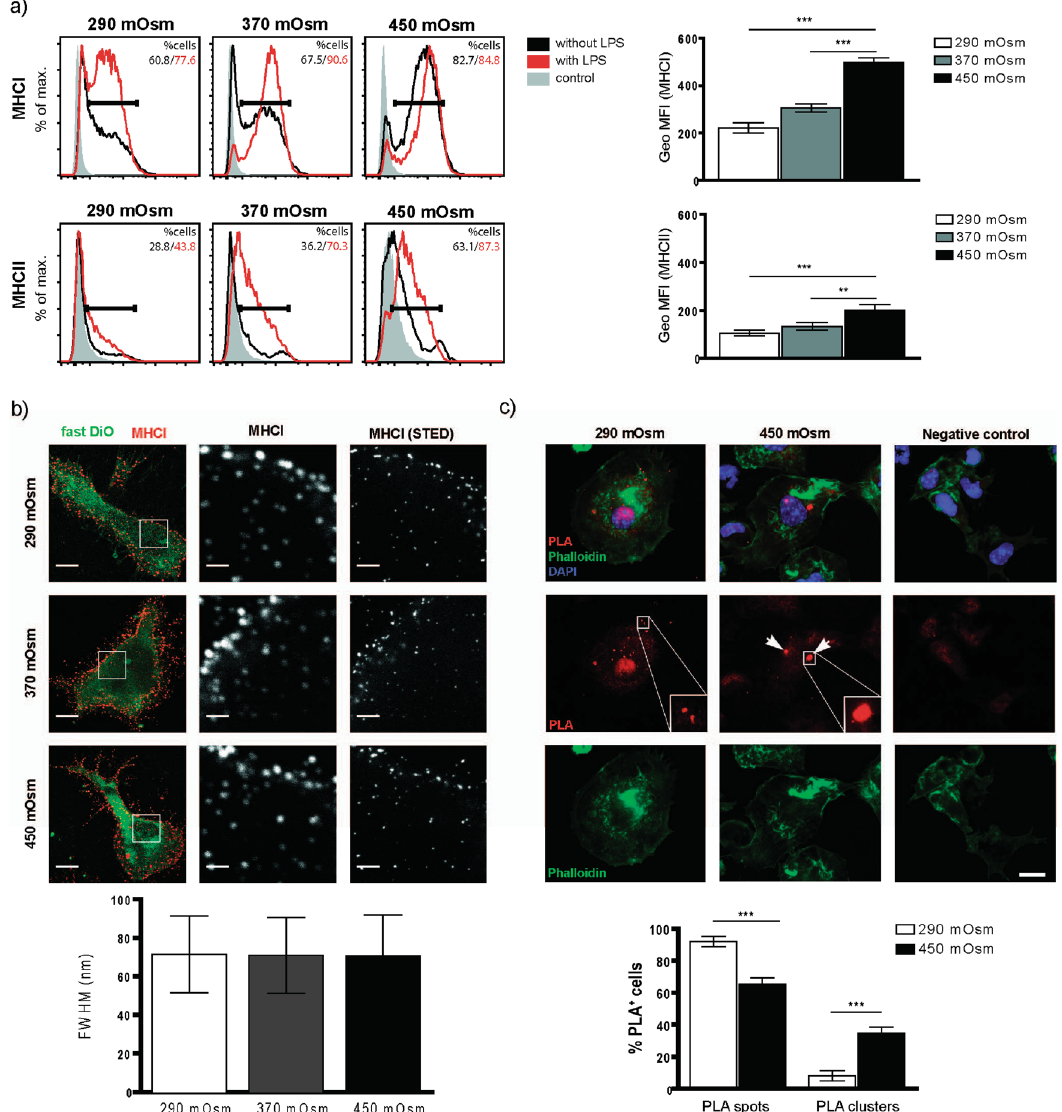
Figure 4. BMDCs matured in NaCl-rich microenvironment have higher surface expression of MHCI and show surface clustering of MHCI-SIINFEKL complex upon OVA uptake. ( a ) Representative histogram plots displaying relative surface expression intensity of MHCI (upper graph) and MHCII (lower graph) by BMDCs from indicated media osmolarities (black contour represents BMDCs raised in LPS-free conditions; red contour shows receptor expression by BMDCs stimulated by LPS) with corresponding statistical graphs showing GeoMFI data for LPS- free samples (right). ( b ) MHCI was immunostained for stimulated emission depletion (STED) imaging in BMDCs cultured in medium with an osmolarity of 290 mOsm, 370 mOsm or 450 mOsm, without addition of OVA. Column 1 shows standard confocal micrographs of MHCI clusters (red) in cells with Fast DiO membrane counterstaining (green) with scale bars indicating 5 μ m. In the areas marked with a white box, MHCI was imaged using STED superresolution microscopy (column 3) and for comparision with the same settings without STED (column 2). Scale bars indicate 1 μ m (101–171 clusters from 13–15 cells per condition, one experiment). Analysis of the MHCI cluster size revealed a similar full width at half maximum (FWHM) of around 71 nm for all three culturing conditions. ( c ) BMDCs cultured in 290 mOsm (left column) and 450 mOsm (middle column) plated on cover slips were incubated with 0.5 mg/mL OVA for 4 hours, fixed and stained in a proximity ligation assay (PLA) with anti-MHCI antibody and 25D1.16.APC antibody. PLA-spots (visible only in the case of specific binding of both antibodies in each other’s proximity) and –clusters (defined as a convincing grouping of multiple spots) were detected using Keyence BZ-9000 microscope (enlarged in the areas marked with a white box). A weak red fluorescence background in the nuclear area is occasionally observed. Scale bar indicates 10 µ m. The right column shows negative control, omitting the anti-MHCI antibody. Statistical analysis (lower graph) demonstrates distribution of spots and clusters in 290 mOsm and 450 mOsm groups, displayed as % of PLA-positive cells having either spots or clusters. The data are displayed as mean ± SEM from two pooled experiments ( *** p ≤ 0.001, n = 19–30 high power